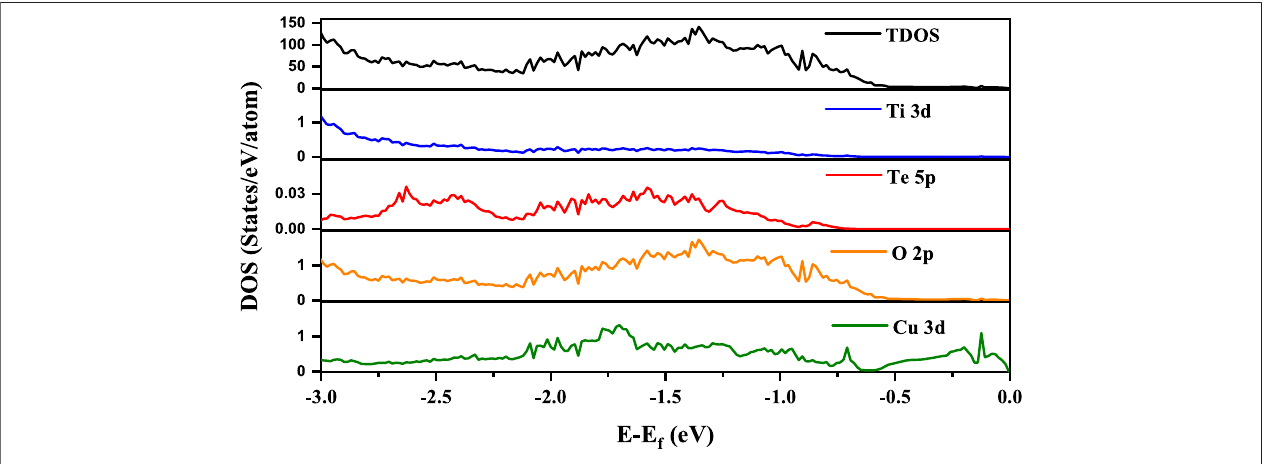
FIGURE 5 | PDOS for Ti 3d, Te 5p, O 2p and Cu 3d for the studied con fi guration IV in addition to the total density of states. The zero of energy is the valence band maximum in our